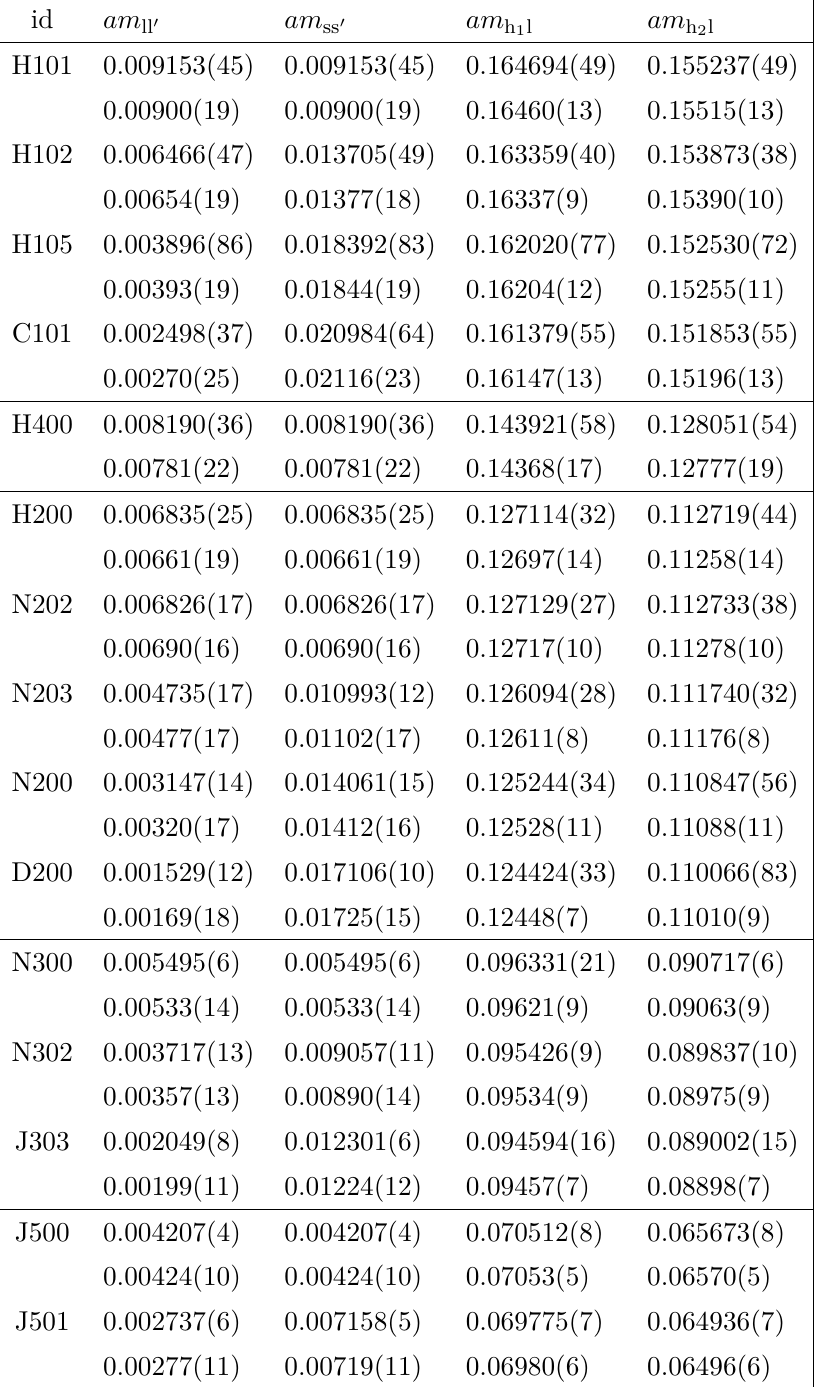
Table 8 . Overview of the results for light-light, strange-strange and heavy-light PCAC quark masses from improved lattice derivatives, where the heavy quark hopping parameter choices in the charm region refer to table 2. As before, for every ensemble we list the numbers before the shift in the rows with labels and the corresponding ones after the shift to φ phys Analogous results from standard lattice derivatives are collected in table